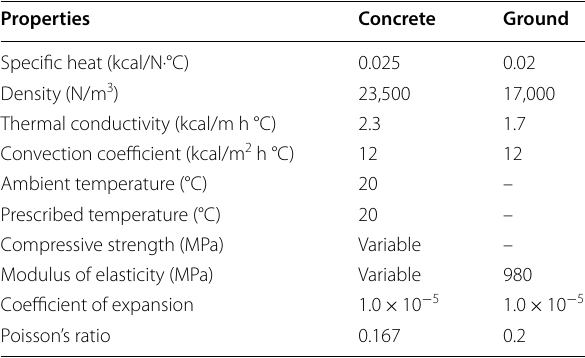
Table 5 Thermal and mechanical properties of concrete and